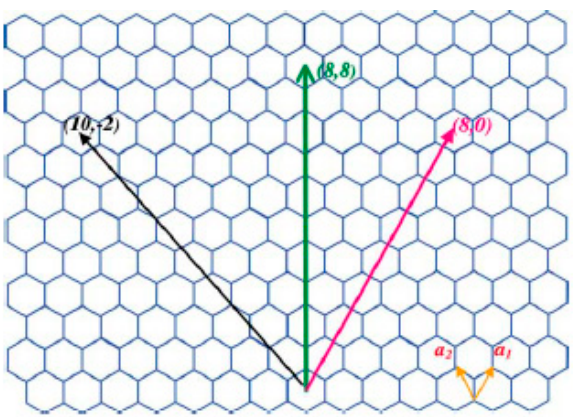
Figure 5. Illustration of graphene sheet’s honeycomb structure. Carbon atoms form the vertices. Folding the sheet in the direction of the lattice vectors can produce SWNTs. Reprinted/adapted with permission from Dai et al. [19] (2002) Elsevier Copyright.